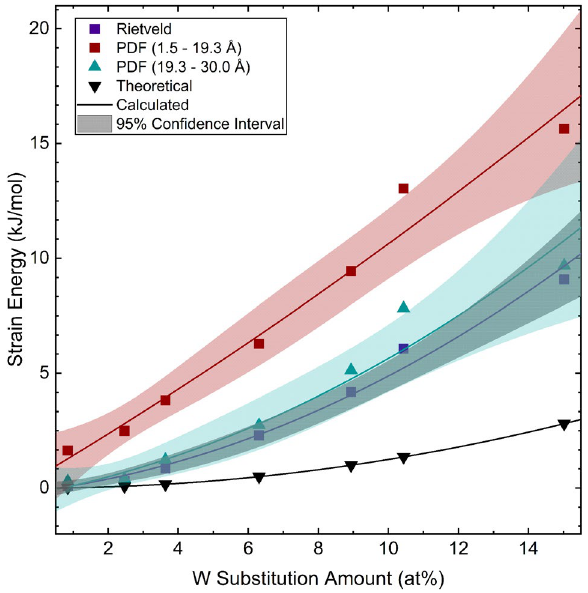
Figure 2. Local approximate strain is greater than long-range strain from PDF and Rietveld refinements. Both local and long-range strain are greater than theoretical strain calculated from effective ionic radii differences between W and